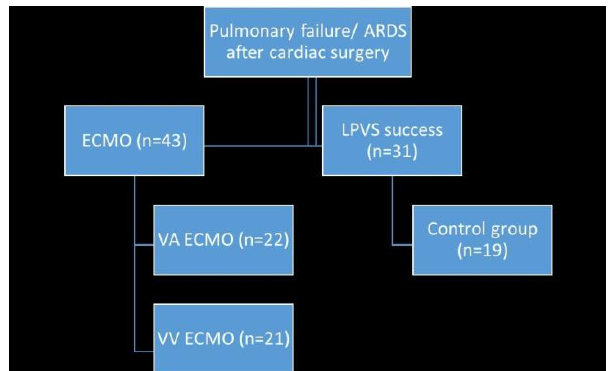
Figure 1: The flowchart of the study population which was composed of VV ECMO and control groups. ARDS: Acute Respiratory Distress Syndrome; ECMO: Extracorporeal Membrane Oxygenation; LPVS: Lung-Protective Ventilation Strategy; VA: Venoarterial; VV: Venovenous.